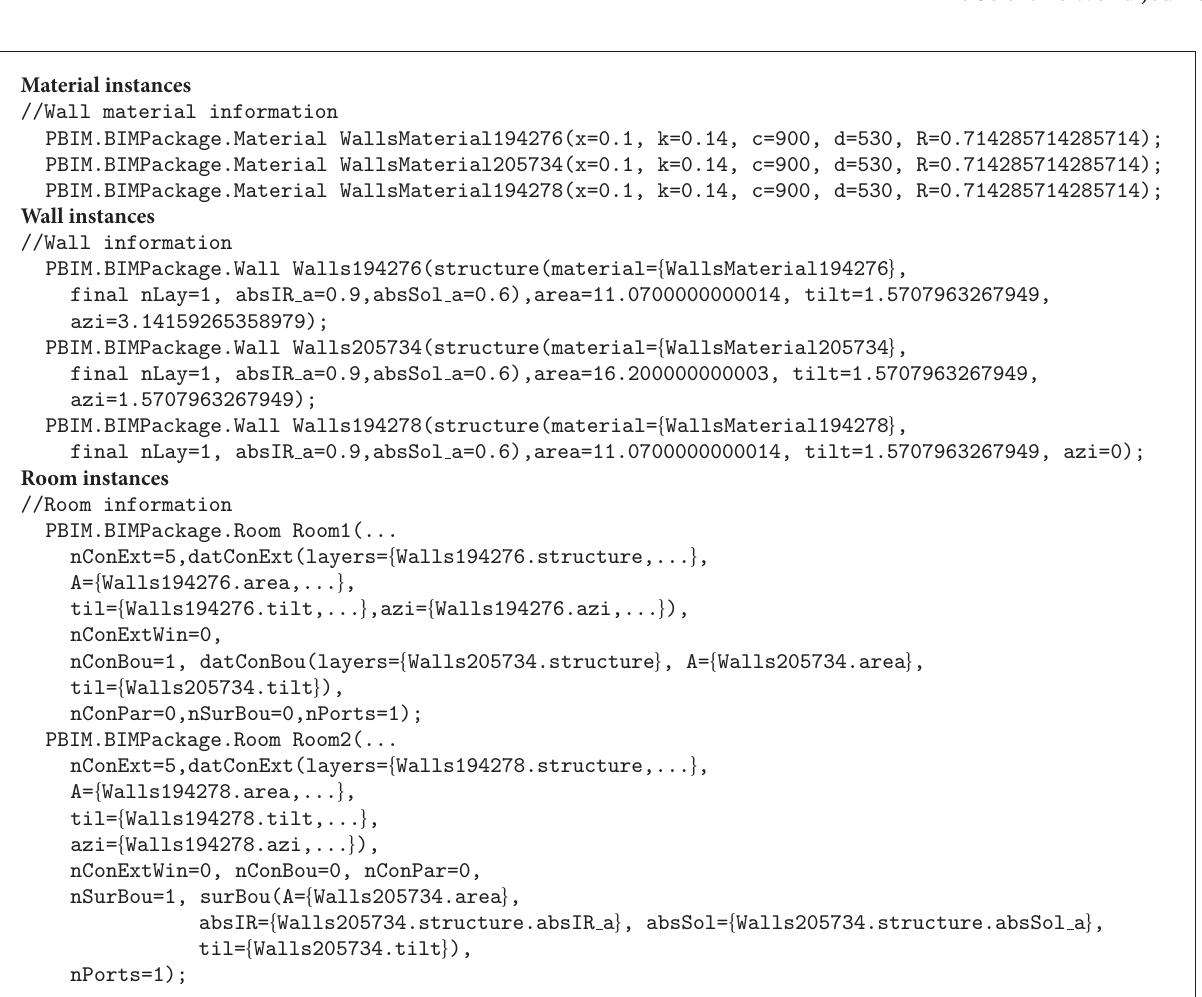
Algorithm 3: A code block of the generated ModelicaBEM presenting material objects for wall objects, the wall objects, and room